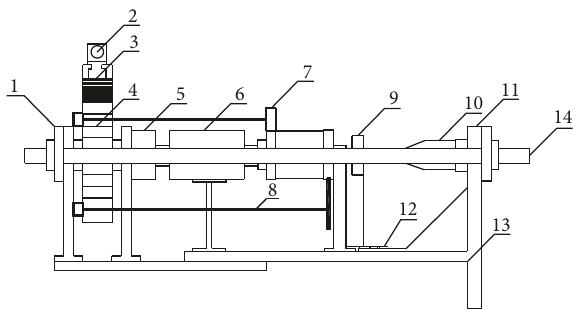
Figure 1: The shear test